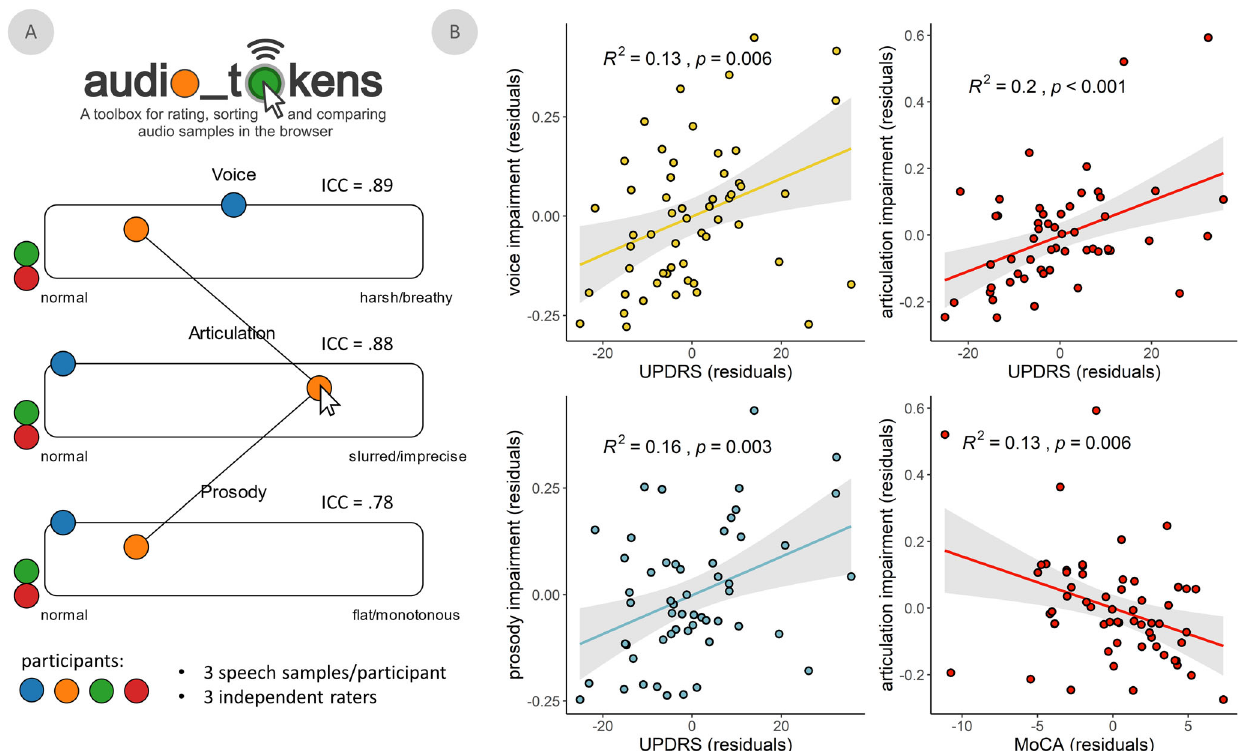
Fig. 1 Speech impairment ratings are reliable and associated with clinical features of PD. A Graphical user interface for the manual rating of speech feature impairments using audio_tokens . When hovered-over with the mouse, colored circles play speech samples from separate patients with Parkinson ’ s disease (each represented by a different color), allowing for interactive and comparative rating (i.e., by clicking and sliding the circles horizontally) of impairments in each speech feature. Intraclass correlation coef fi cients (ICC) indicate reliability of speech ratings across three independent raters. B Signi fi cant linear relationships between voice, articulation, and prosody impairments and two common clinical scales in Parkinson ’ s disease: the Uni fi ed Parkinson ’ s Disease Rating Scale part III (i.e., UPDRS-III, minus speech sub-scores) and the Montreal Cognitive Assessment (MoCA). All models controlled for age. Shaded intervals represent the 95% con fi dence